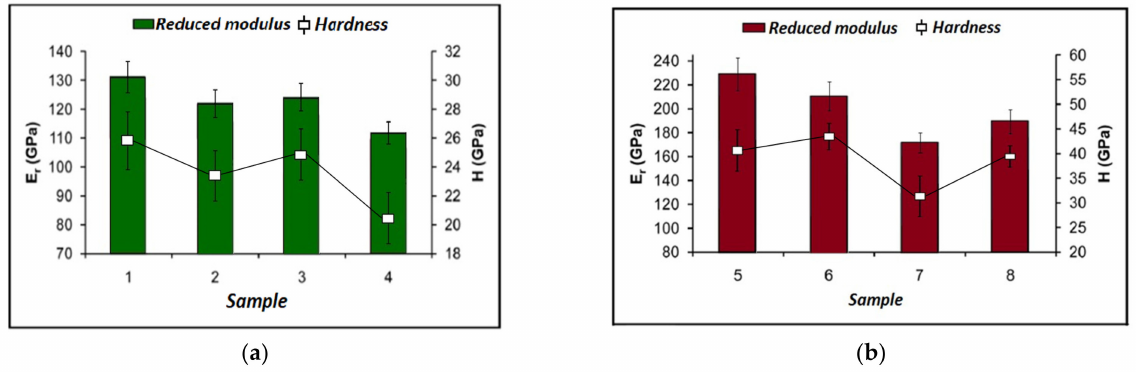
Figure 9. ( a ) Plots of E r and H data from 45 µ N nanoindentation tests on 50 nm TiN thin-film samples; ( b ) data from 60 µ N nanoindentation tests on 150 nm TiN thin-film samples.